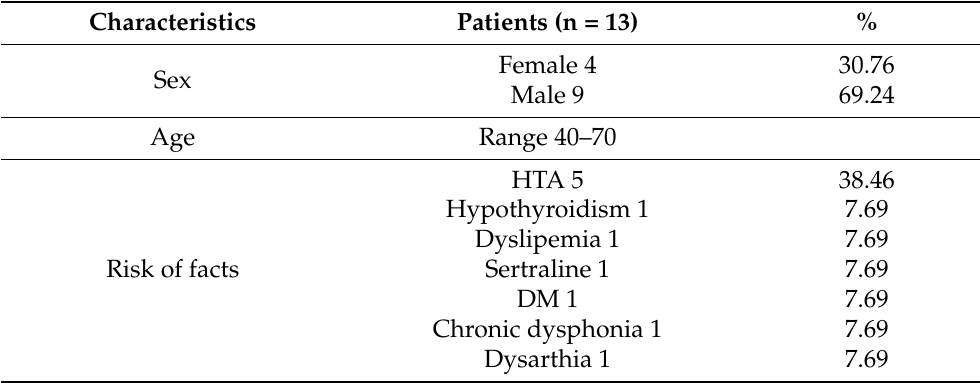
Table 1. Clinical and demographic characteristics of